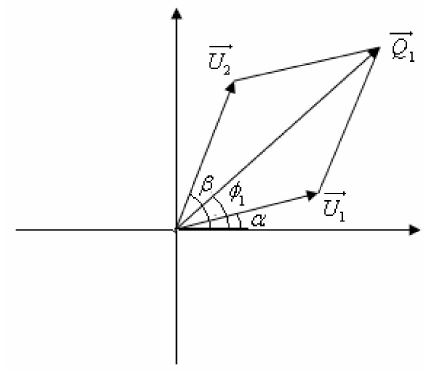
Figure 1. The synthetic principle of the correcting vector in a